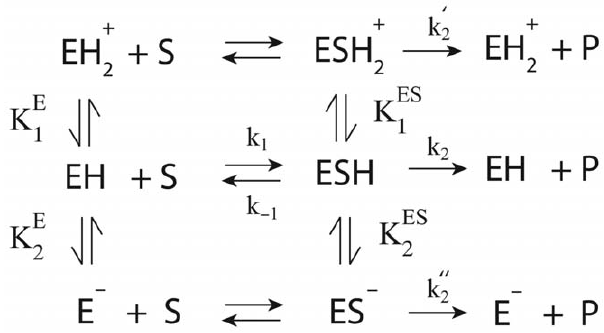
Figure 10. Reaction scheme of diprotic model. E represents the enzyme as a weak diprotic acid with its three protonation states EH 2 + , EH and E 2 . The dissociation constants K 1E , K 2E , K 1ES and K 2ES describe rapid protonization equilibria of the free enzyme and the enzyme with bound substrate, i.e., K 1 E = [H + ][EH]/[EH 2 + ], K 2 E = [H + ][E 2 ]/[EH], K 1ES =[H + ][ESH]/[ESH 2 + ], K 2ES =[H + ][ES 2 ]/[ESH]. For the sake of simplic-